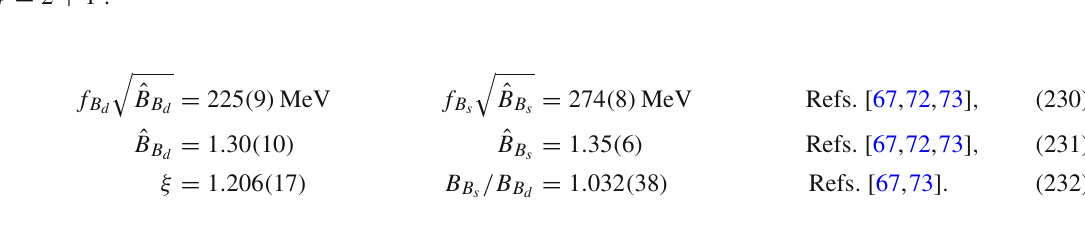
stout link smearings in the heavy DWF, the reach to heavy mass is improved, which allows them to simulate up to half of the physical bottom mass. Two ensembles are of physical ud quark mass at a = 0 . 11 and 0 . 09 fm, and there is yet another ensemble off the physical point but with finer lattice spacing, a = 0 . 07 fm. This is the first computation using physical light-quark mass for these quantities, which yields a drastic reduction of the chiral extrapolation